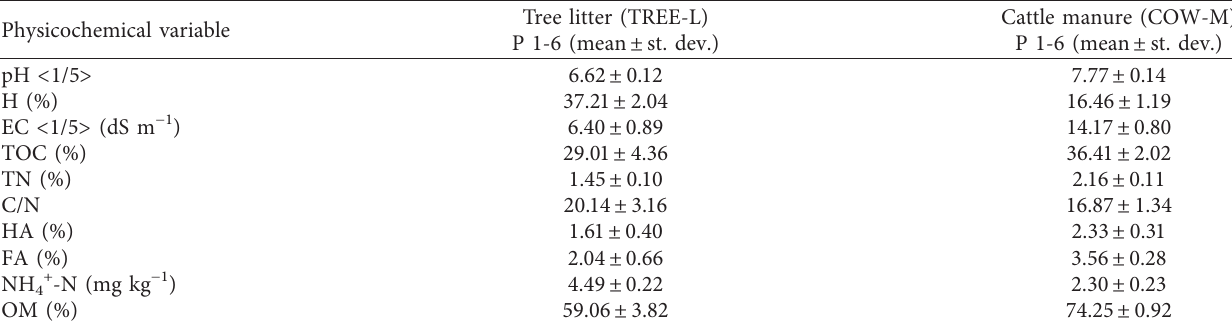
Table 2: Physicochemical variables of raw materials used in the evaluation stage composting ( n �